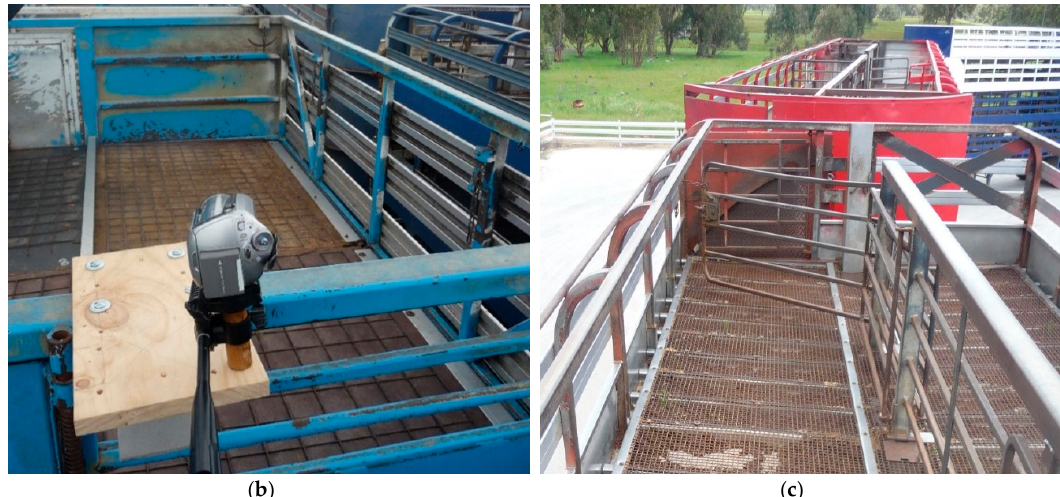
Figure 2. View showing ( a ) sides of a standard 4-tier commercial sheep transport vehicle, ( b ) sides of the top deck of a convertible, and ( c ) top deck of a standard crate.